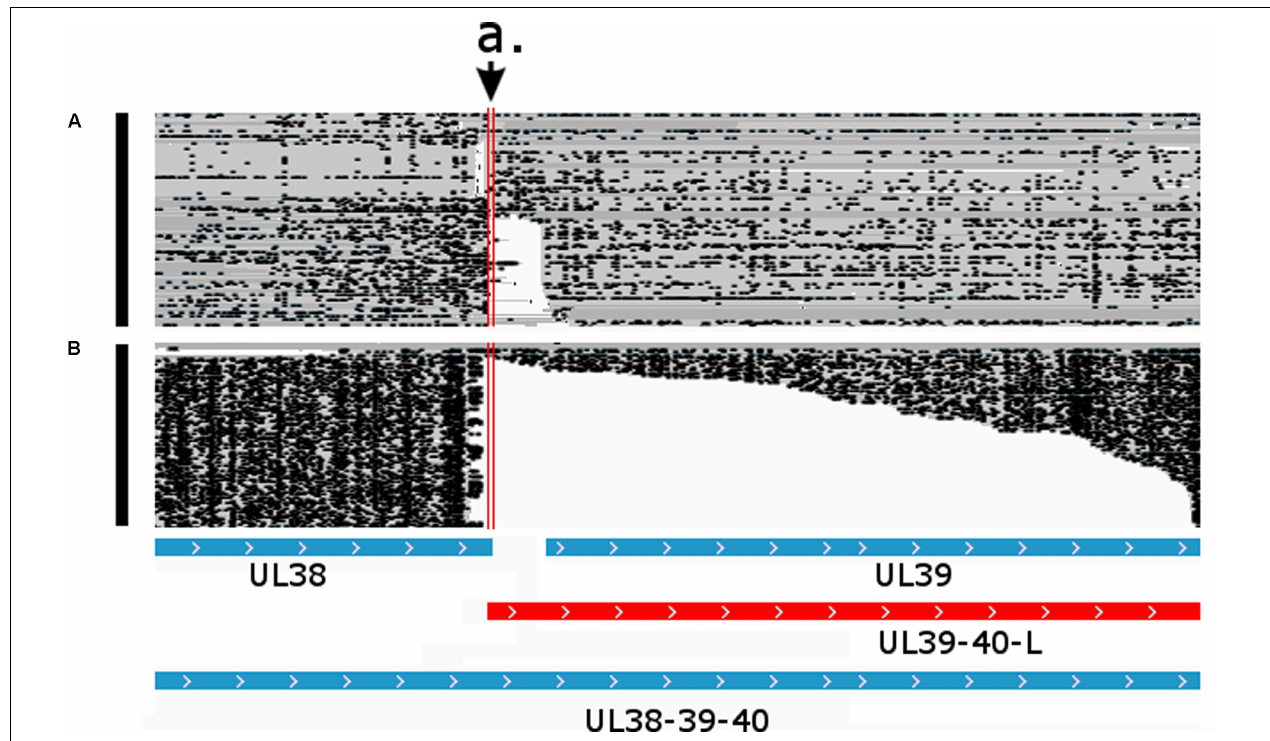
FIGURE 8 | Parallel transcriptional overlap of the UL38 and UL39-40-L transcripts. The arrow a. points to the overlapping region delimited by the vertical red lines. Blue boxes represent already known transcripts, while the red box represents the novel UL39-40-L transcript. Reads of the PacBio IsoSeq (A) and MinION Direct RNA (B) sequencing were visualized in compact mode using